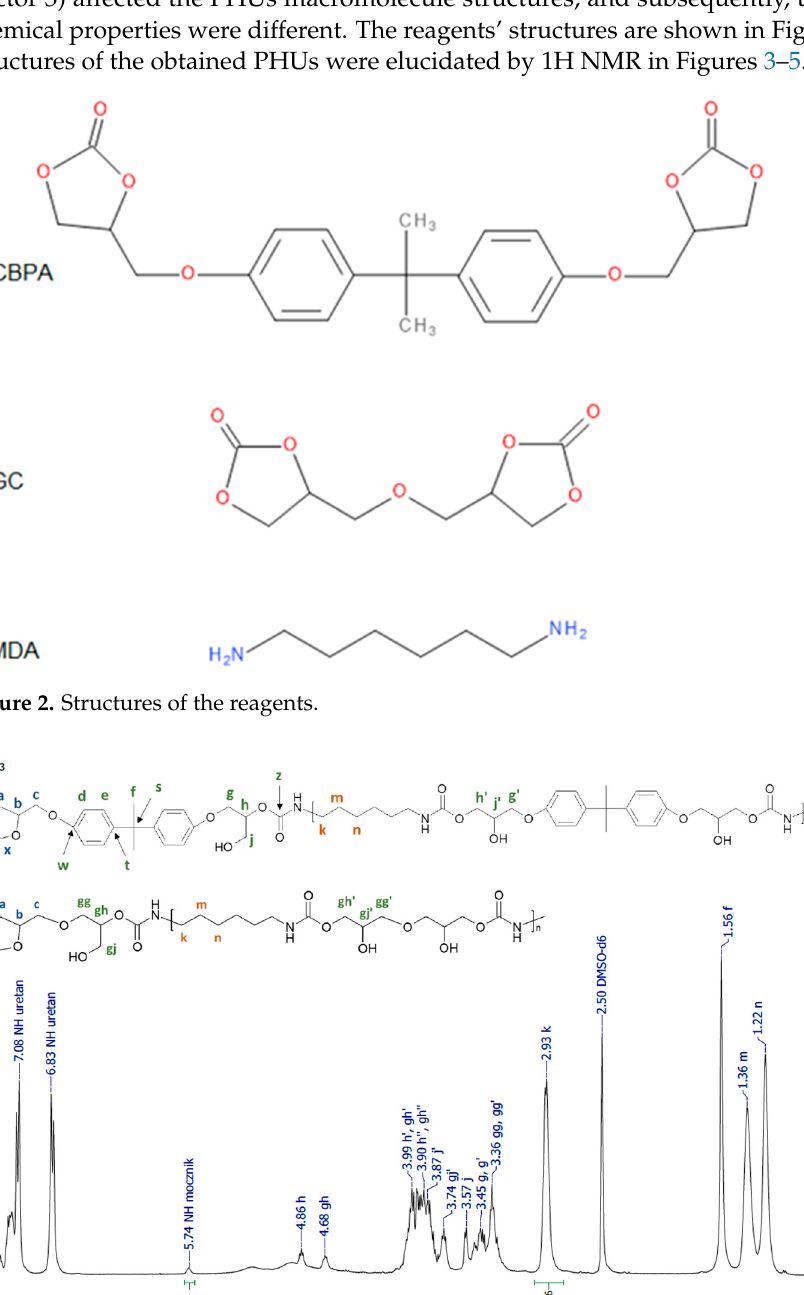
Figure 4. A representative 1H NMR spectrum of PHU obtained in experiment run nos. 5, 6, 9 and 10.